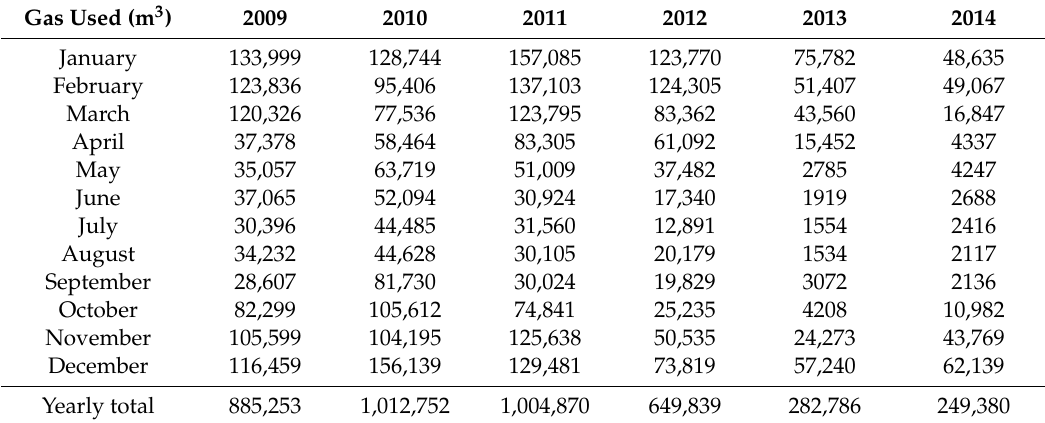
Table 1. Past data for natural gas usage of the manufacturing plant. These data are used to predict future demands.